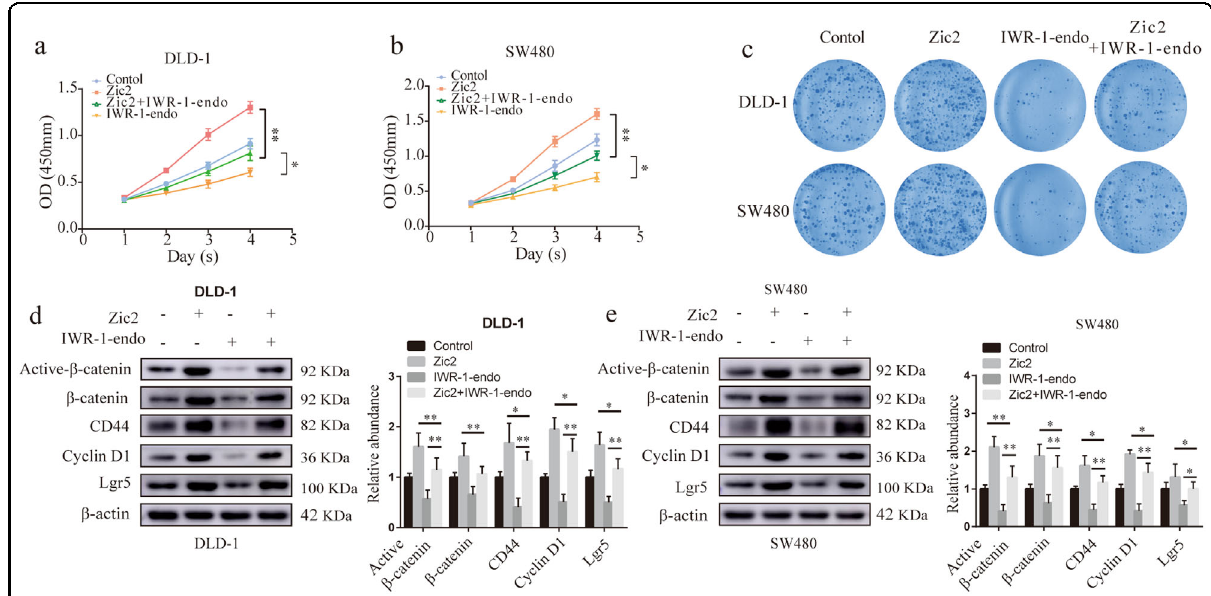
Fig. 6 Zic2 downstream factor Axin2 contributes to colon cancer cell growth and Wnt/ β -catenin activation. a – c CCK8 proliferation assay ( a , b ) and colony formation ( c ) were assessed in cell lines transfected with Zic2 or the vector treated with IWR-1-endo. d , e Western blotting bands for Cyclin D1, CD44, Lgr5, active β -catenin (Ser 45), and β -catenin were detected in DLD-1 ( c ) and SW480 ( d ) transfected with Zic2 or the vector treated with IWR-1-endo. All data are presented as the mean ± SD from three independent experiments. * P < 0.05, ** P <